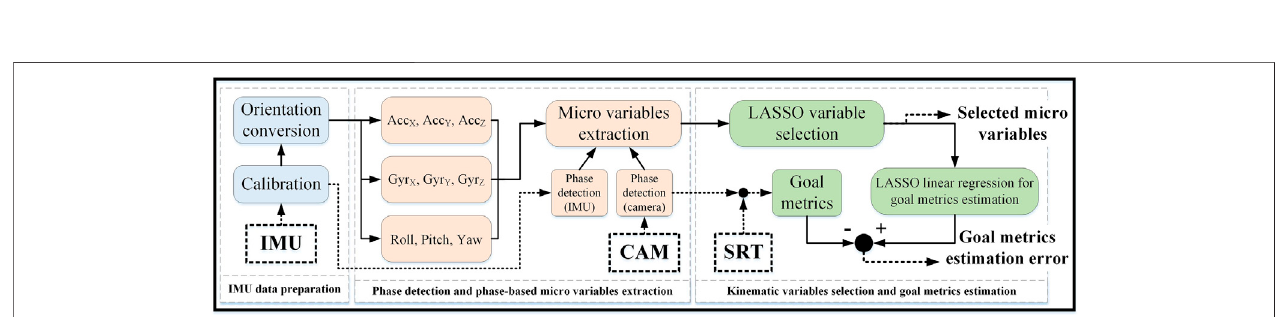
FIGURE2| Flowchartoftheperformanceevaluationalgorithm.IMUdatapreparationincludingIMUcalibrationandexpressingdataintheglobalframe (left), phase detection bycameras(CAM)orIMU calibrated dataand micro variableextraction from IMUdata inglobal frame (middle) and variableselectionfrommicro variablesand the goal metrics estimation (right). The actual goal metrics are de fi ned and extracted from the velocity and displacement data by tethered speedometer (SRT) during swimming phases separated by the cameras (CAM).